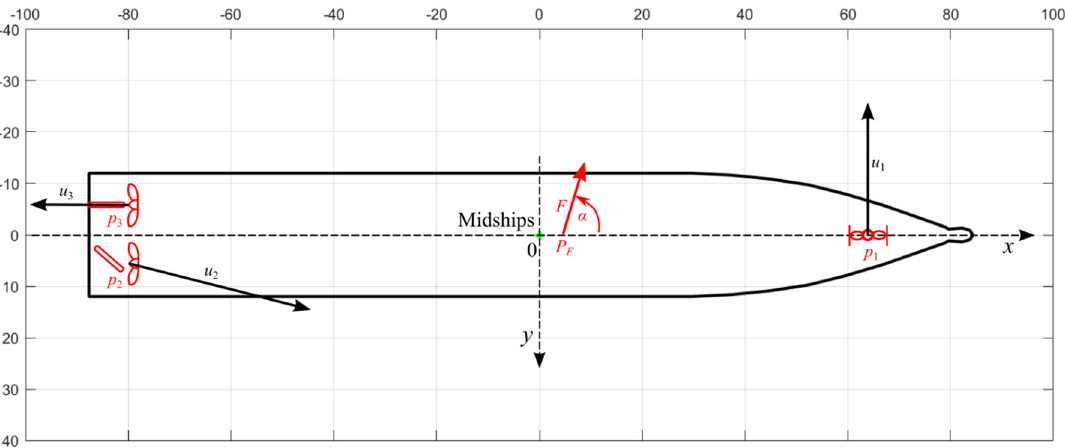
Figure 1. Ship dimensions and positions of thrusters in ship-body reference frame, and visualisation of the ferry.